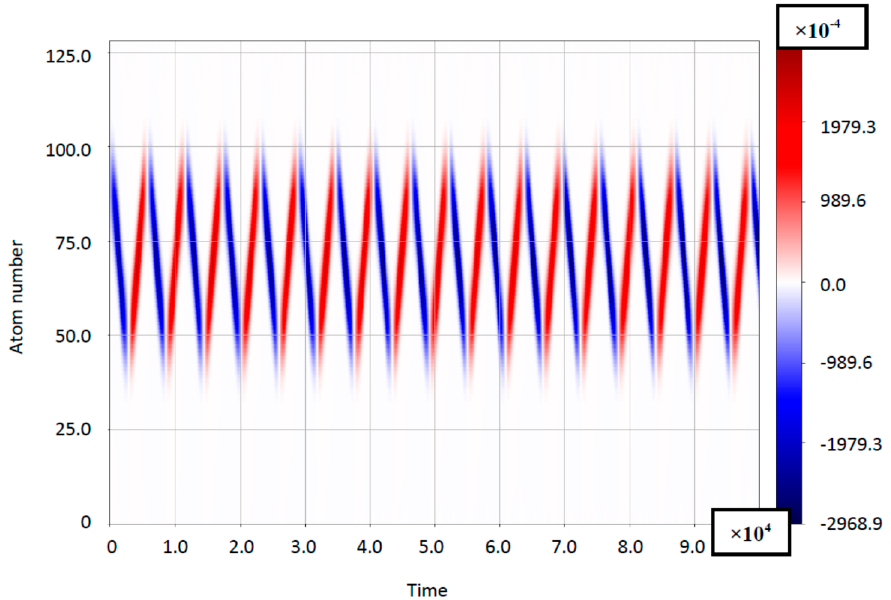
Figure 20. Space–time distribution of tunneling current density with Stark effect. All parameters are identical to Figure 19.